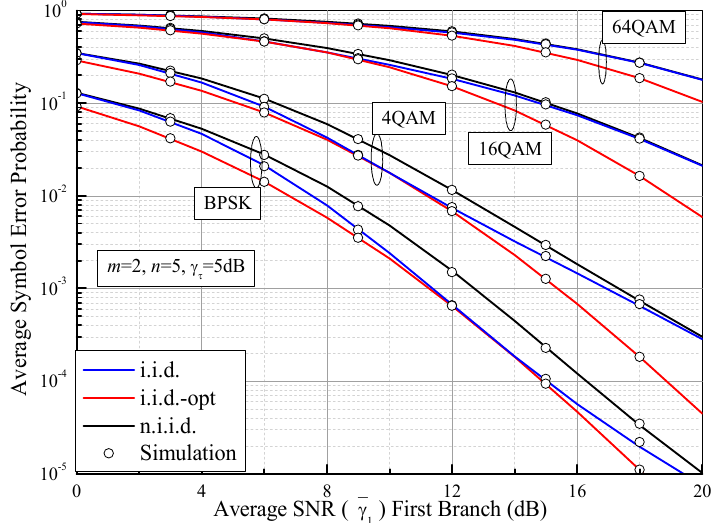
Figure 9. ASEP values of BPSK and MQAM for the SSC system as a function of the average SNR of the first branch ( 𝛾̅ (cid:2869) ) over Fisher–Snedecor ℱ fading channels with m = 2, n = 5, and γ (cid:3099) = 6 dB. Based on (90), (92), (93) and (94), the average capacity per unit bandwidth of the switched diversity systems as a function of the average SNR of the first branch ( 𝛾̅ (cid:2869) ) over Fisher–Snedecor ℱ fading channels with m = 2, n = 5, and γ (cid:3099) = 6 dB is depicted in Figure 10. As a comparison, the average capacities of the PSC (i.i.d.) and single ‐ branch system